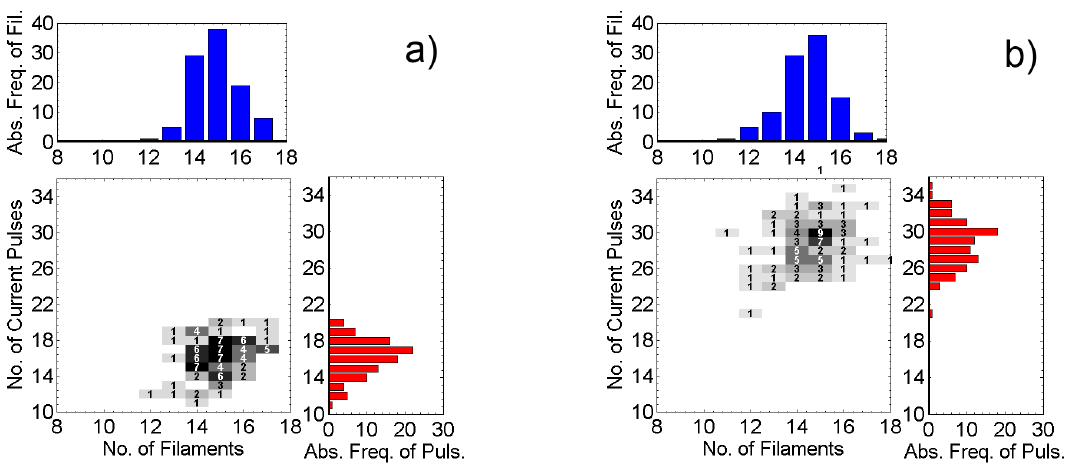
Figure 10 : Relation matrix of incidence, DCSBD at voltage amplitude 16 kV and electrode gap 0.6 mm; a) positive half-period, b) whole period of discharge.